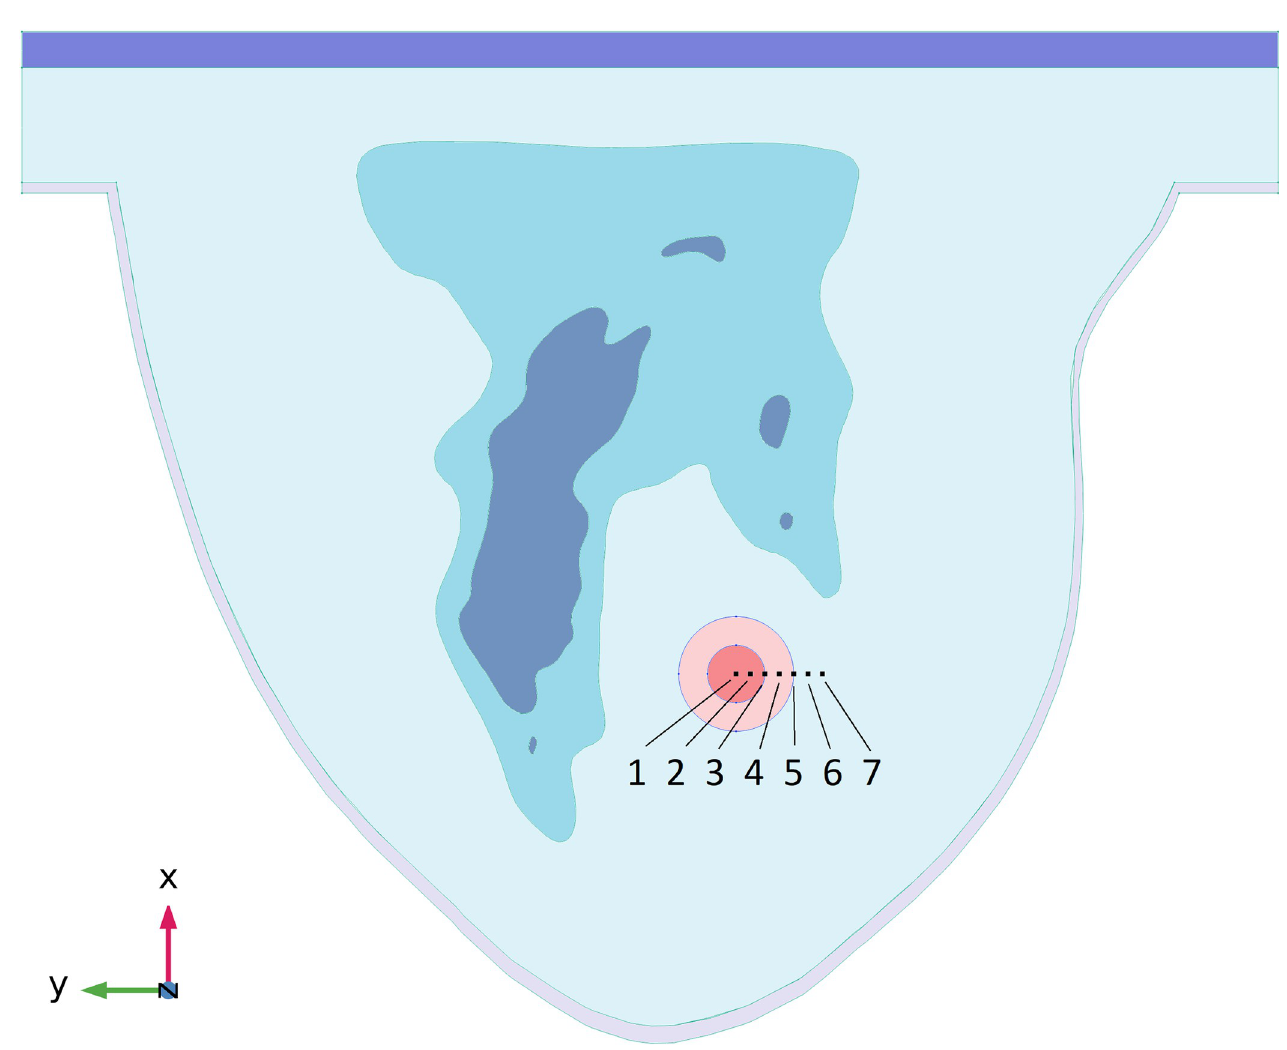
Fig 7. Position of observation points and their considered numbers on the cut surface